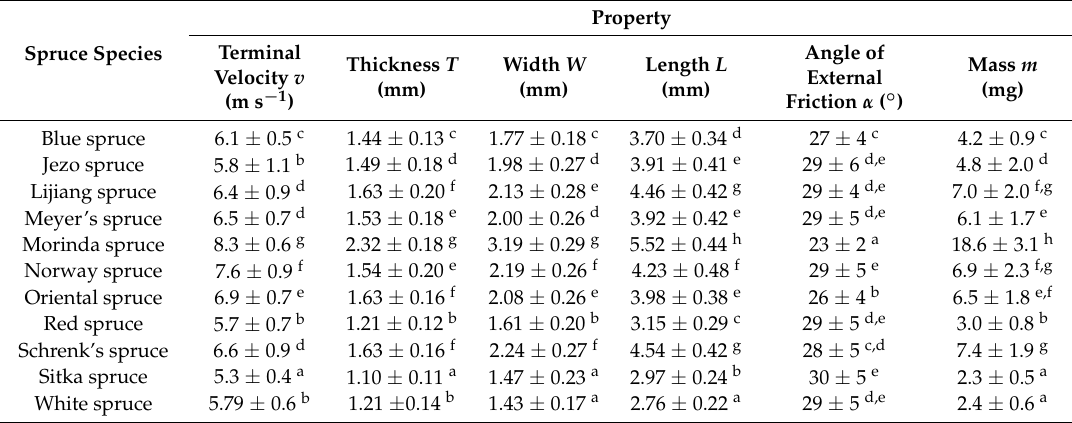
Table 1. Statistical distribution of the physical properties (mean value ± standard deviation) of seeds in selected spruce species and significant differences between